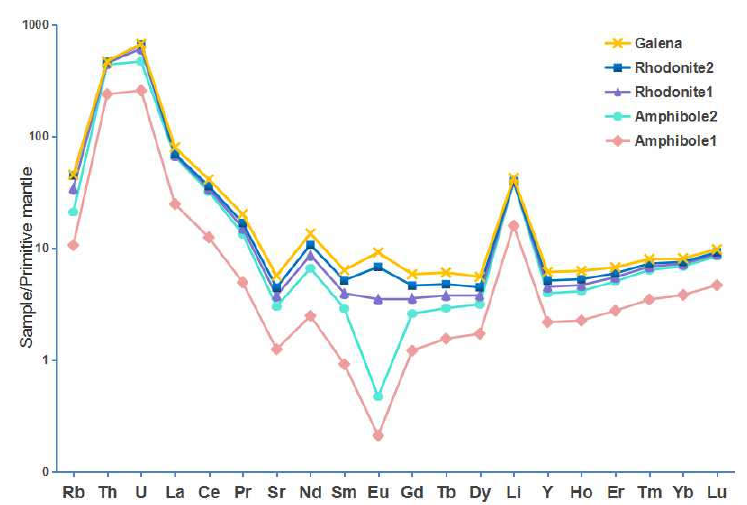
Figure 8. Spider diagrams of trace elements in JingFencui deposit (primitive mantle normalization values after Sun and McDonough, 1989 [17]).